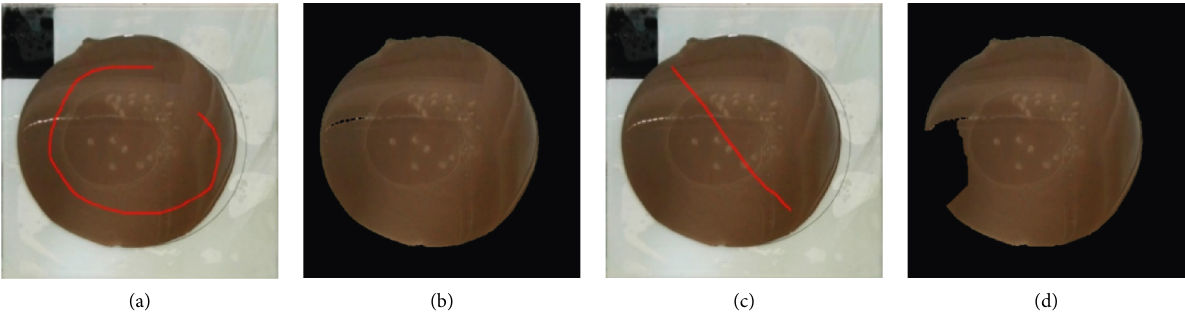
Figure 6: The segmentation results of GrabCut algorithm: (a) foreground 1, (b) the segmentation result of foreground 1, (c) foreground 2, and (d) the segmentation result of foreground 2.